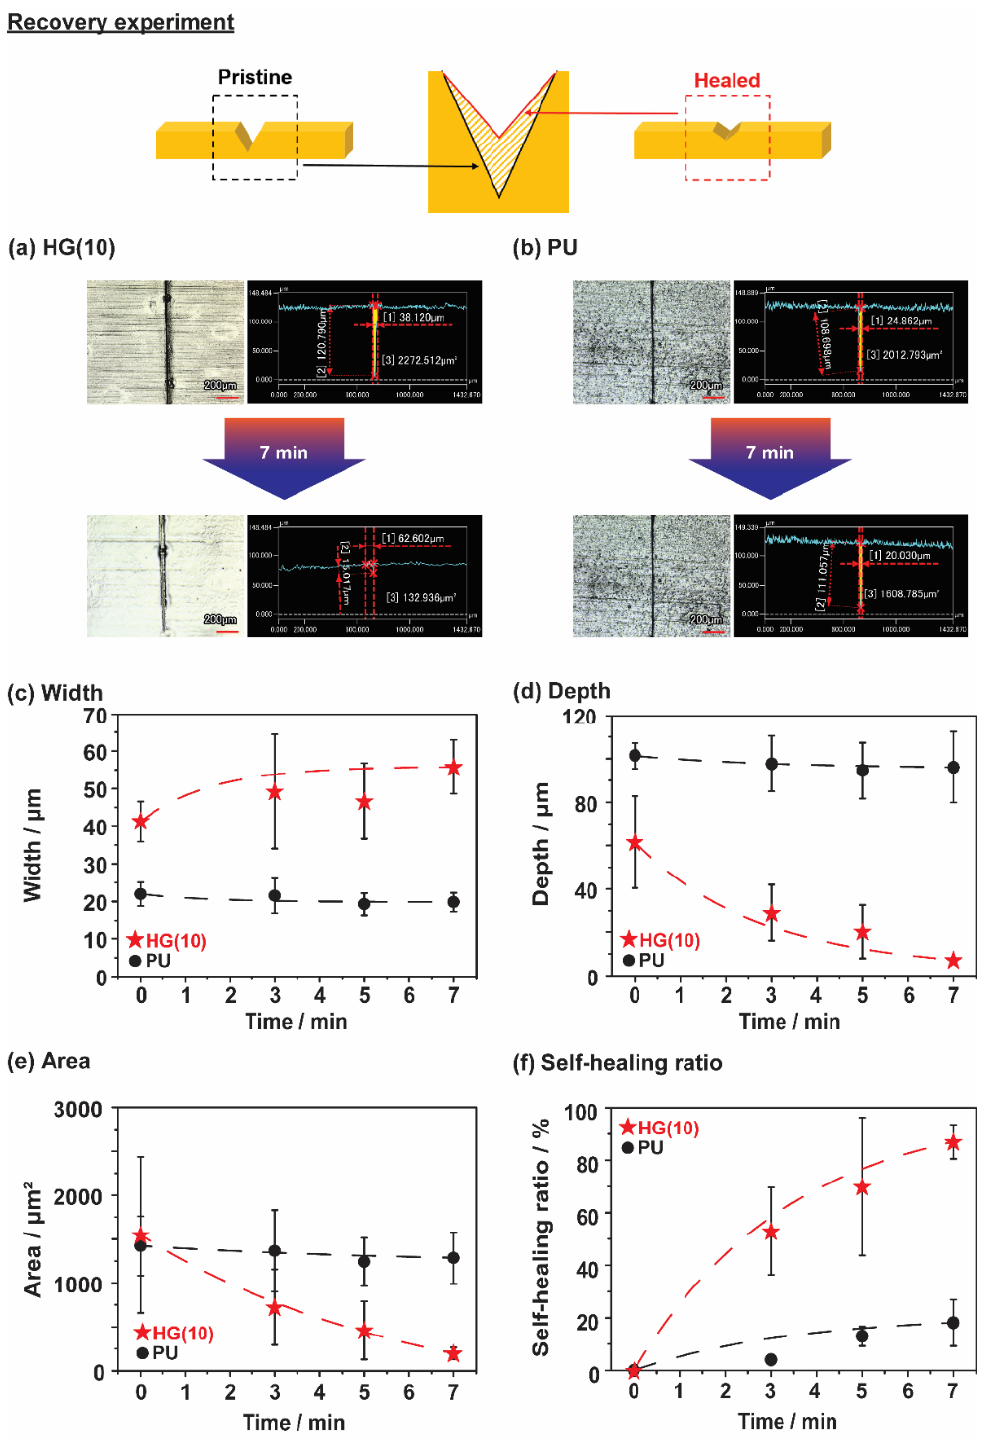
Figure 4. Optical microscopy images of ( a ) HG(10) and ( b ) PU after damaging and placing at 80 °C for 7 min. The scar profiles of HG(10) and PU as ( c ) width, ( d ) depth, and ( e ) area. ( f ) Self-healing ratio of HG(10) and PU calculated from the area.